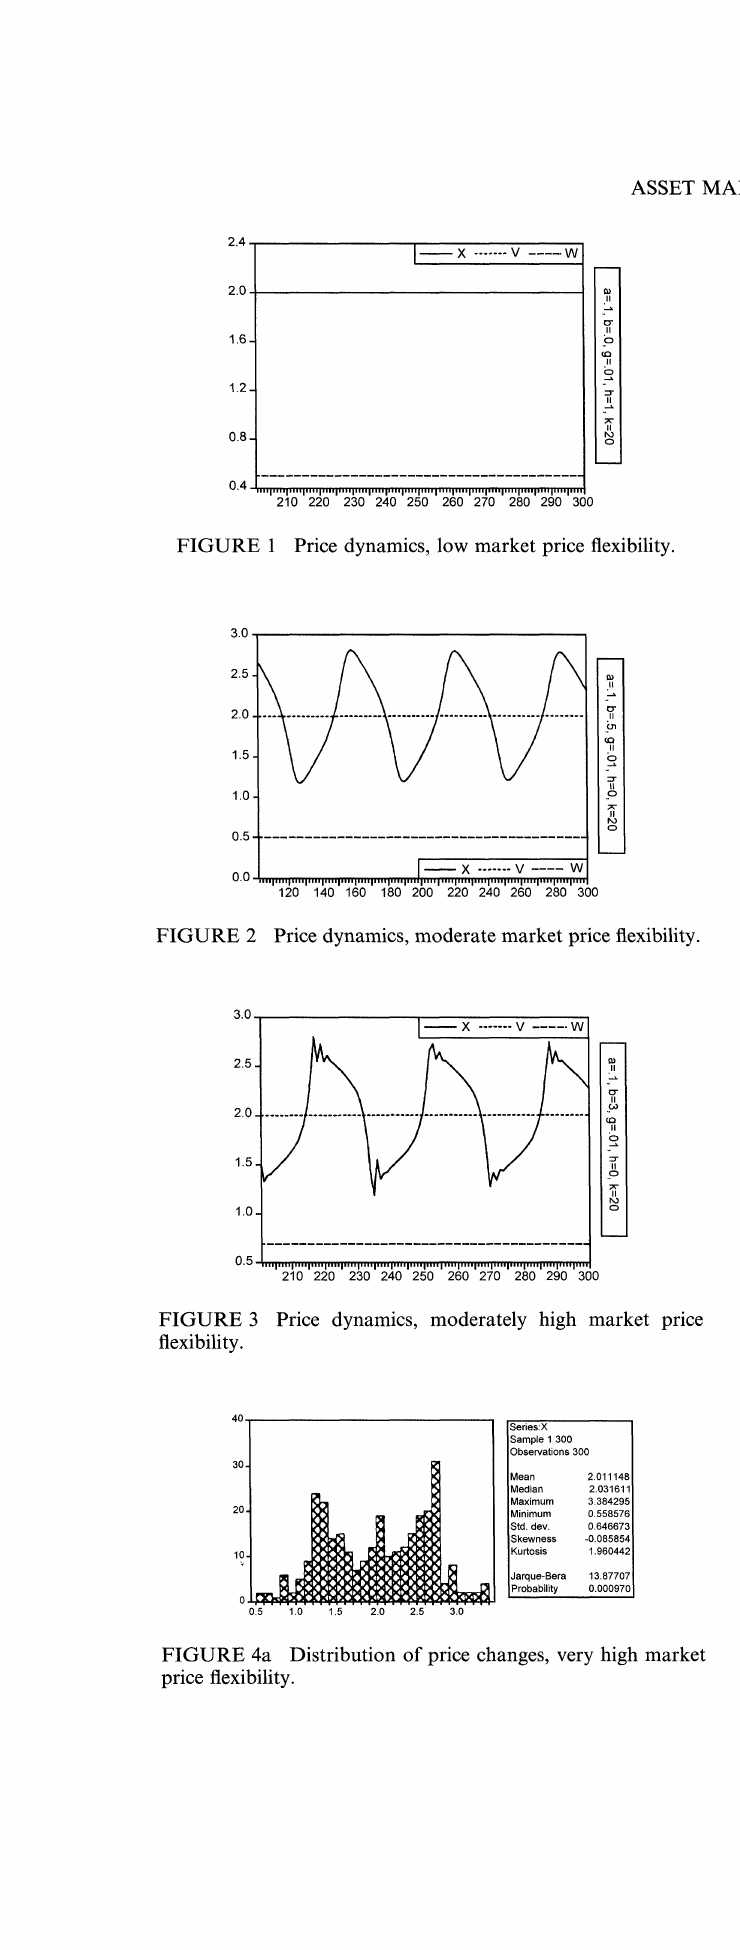
FIGURE Price dynamics, low market price flexibility.